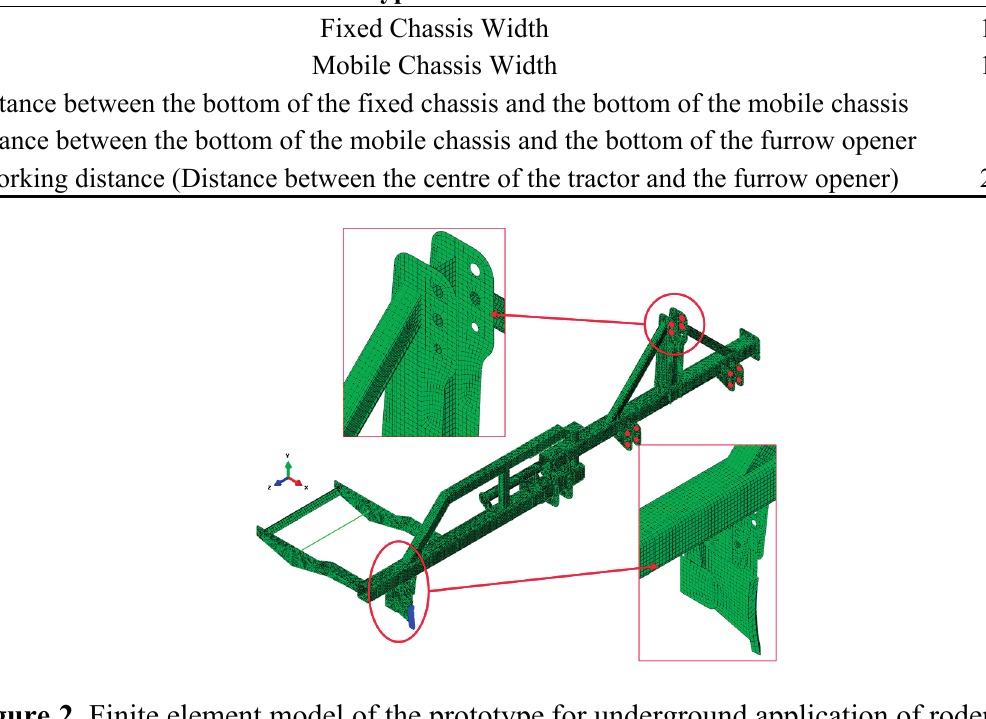
Figure 2. Finite element model of the prototype for underground application of rodenticide bait. Areas of load application (furrow opener, in blue) and boundary conditions (attachment to the tractor, in red).